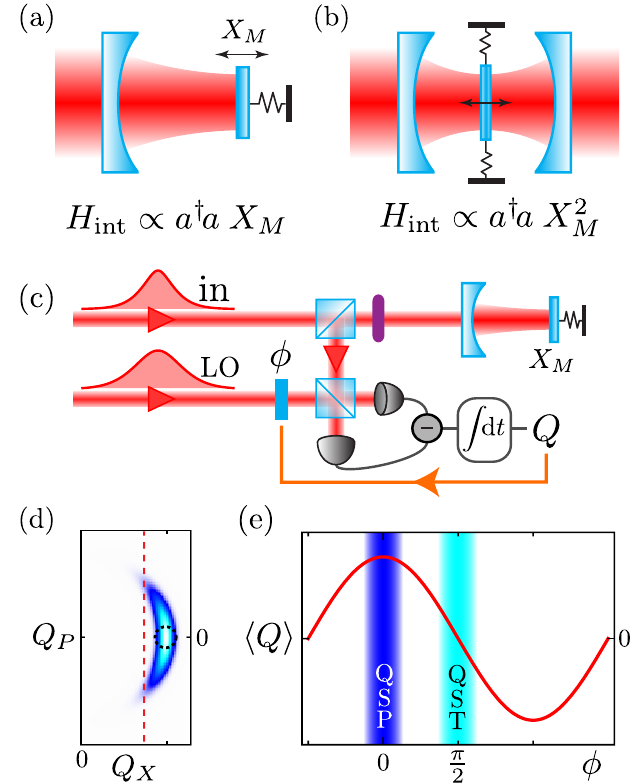
FIG. 1. Cavity optomechanics is currently realized using (a) reflective and (b) dispersive approaches. The interaction in , how- the former is proportional to mechanical displacement X M ever, in the latter the interaction can be tuned to being proportional or X 2 . Pulses of light may be used to probe and manipulate to X M M the motional state of the mechanical resonator. The optical setup considered here (c) is a pulse incident upon an optomechanical and then an optical system with an interaction proportional to X M quadrature measurement performed via homodyne detection. Following the interaction, the Wigner function of the optical field (d) is scimitar shaped due to mechanical-position-induced optical rotations. The distribution of the initial coherent state is indicated by the dashed circle. (The parameters for this plot were chosen to exaggerate the curvature.) For small rotations, is proportional to X and the amplitude the phase quadrature Q P M information. The amplitude-quadrature quadrature carries X 2 M measurement outcome indicated by the red dashed line may have originated from two distinct mechanical positions, which provides a means for superposition preparation. By choosing the phase in (e) homodyne detection one can use the amplitude measurements and quantum-state preparation quadrature for X 2 M or use the phase quadrature for X measurements to perform M quantum-state